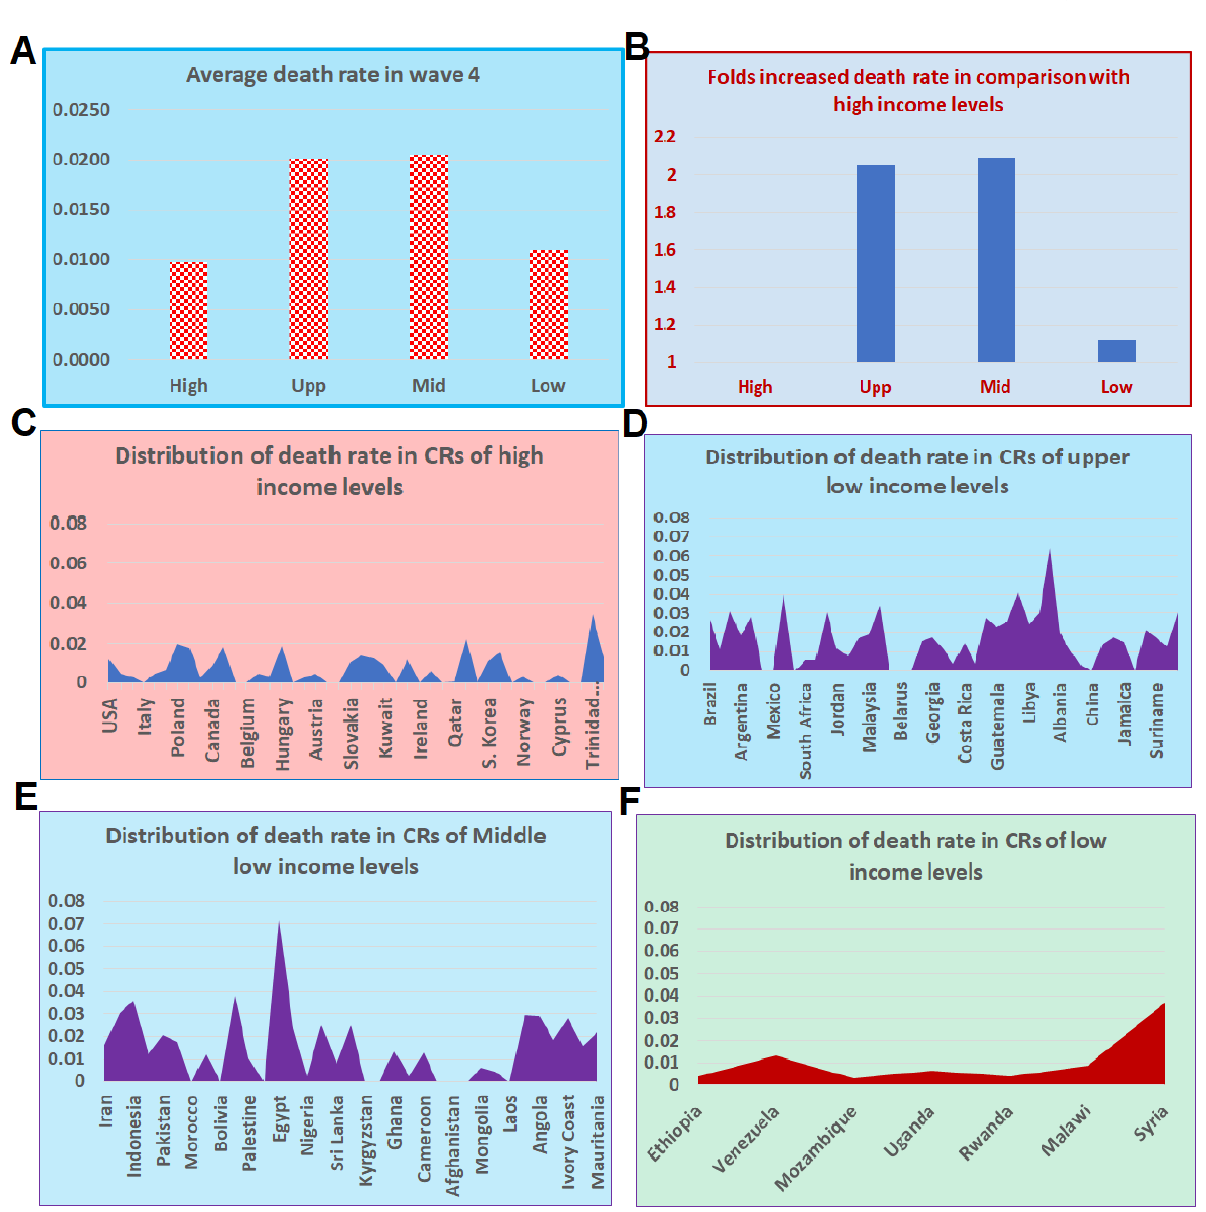
Figure 6. Mortality rates at the turning points during wave 4 of COVID-19 disease in CRs with different income levels. ( A ) Average mortality rates in CRs by income level. ( B ) Fold increase in the upper- and lower-middle, and low income CRs compared to high-income CRs. ( C ) Distributions of mortality rates of CRs at the high-income level. ( D ) Distributions of mortality rates of CRs at the upper-middle-income level. ( E ) Distributions of mortality rate of CRs at the lower-middle-income level. ( F ) Distributions of mortality rate of CRs at the low-income level.